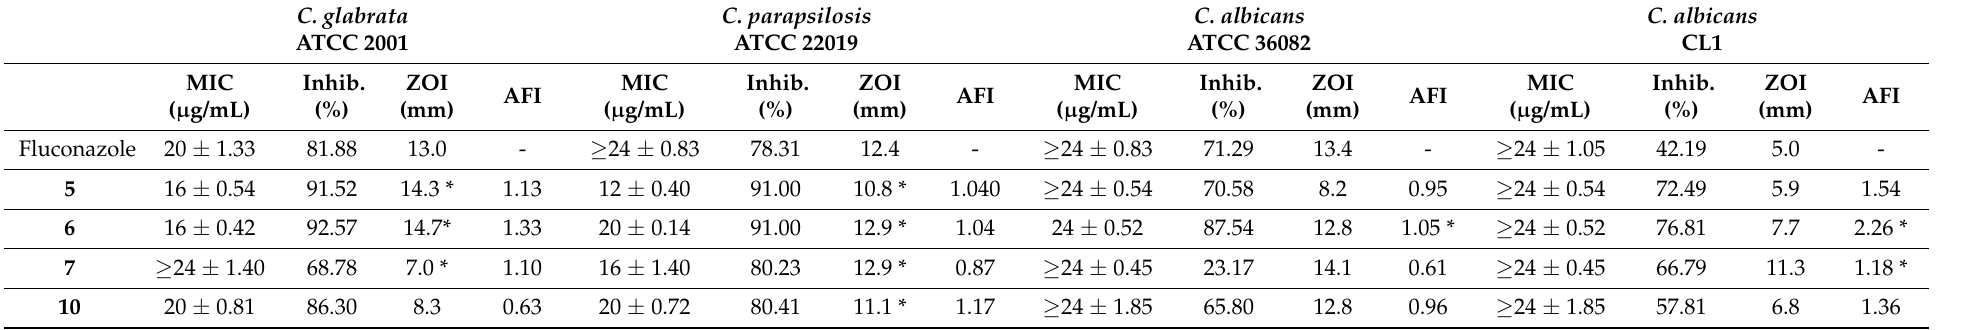
Table 1. In vitro antifungal activity of synthetic compounds against fluconazole resistant Candida species. C.